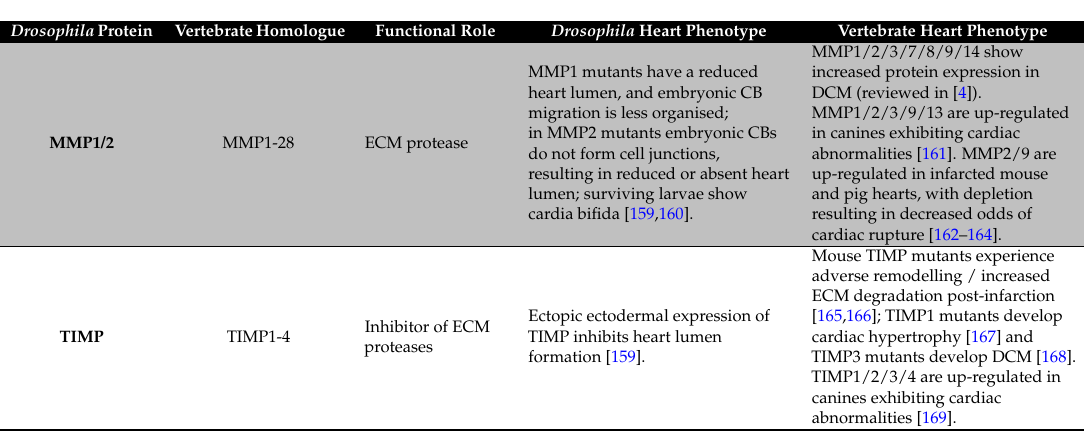
Table 3. Remodelling proteases of the